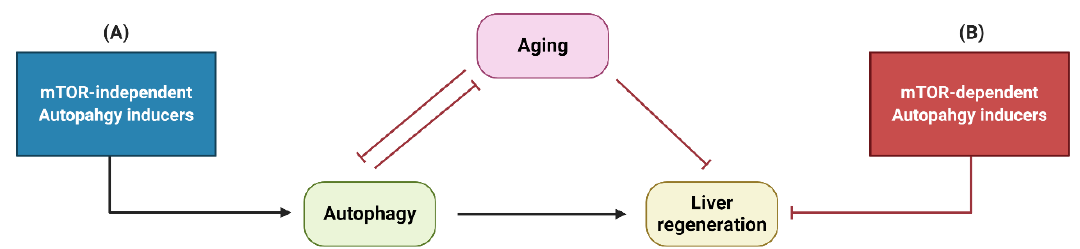
Figure 4. The relationship between autophagy, liver regeneration and aging. ( A ) mTOR-independent autophagy inducers can promote liver regeneration, while ( B ) mTOR-dependent autophagy inducers inhibit liver regeneration.